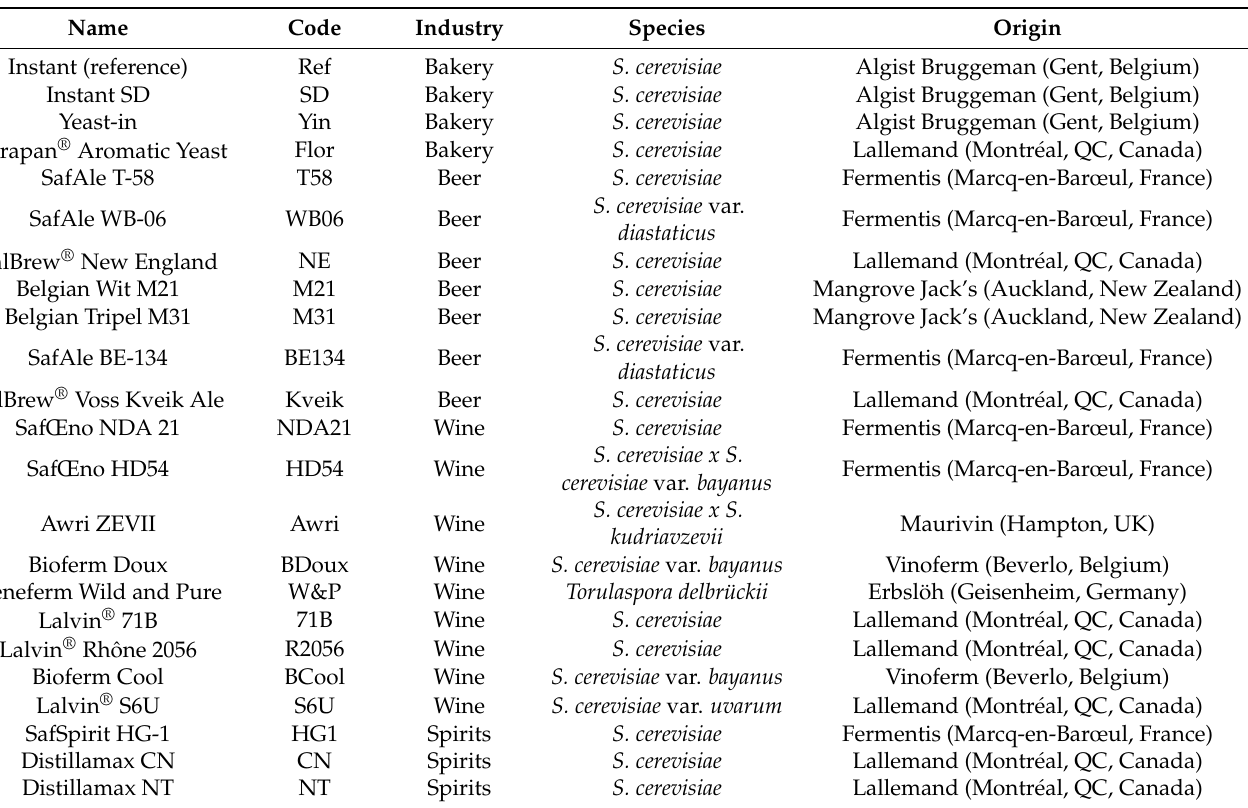
Table 1. Reference baker’s yeast and 22 non-conventional yeast strains from the bakery, wine, beer, or spirits industry. Species and origins are